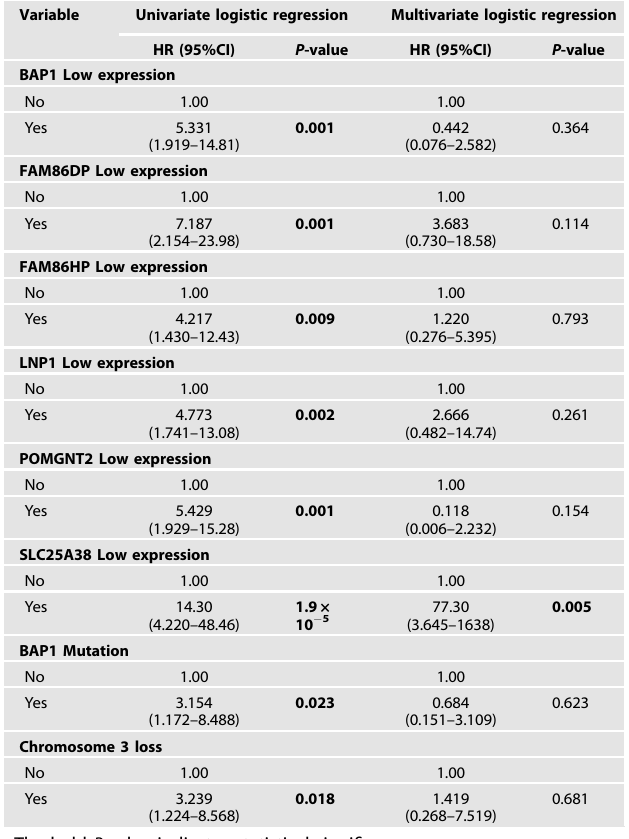
(Fig. 2C, Binary SLC25A38 vs Binary BAP1, P = 0.0415; Binary SLC25A38 vs GEP Class, P = 0.0395).